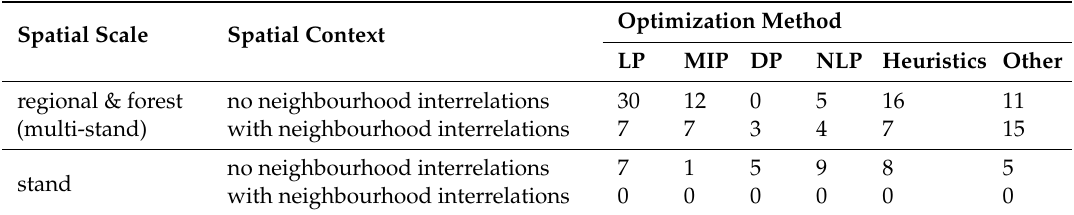
Table 8. Instances of optimization methods used for problems with different spatial scales and contexts. Spatial